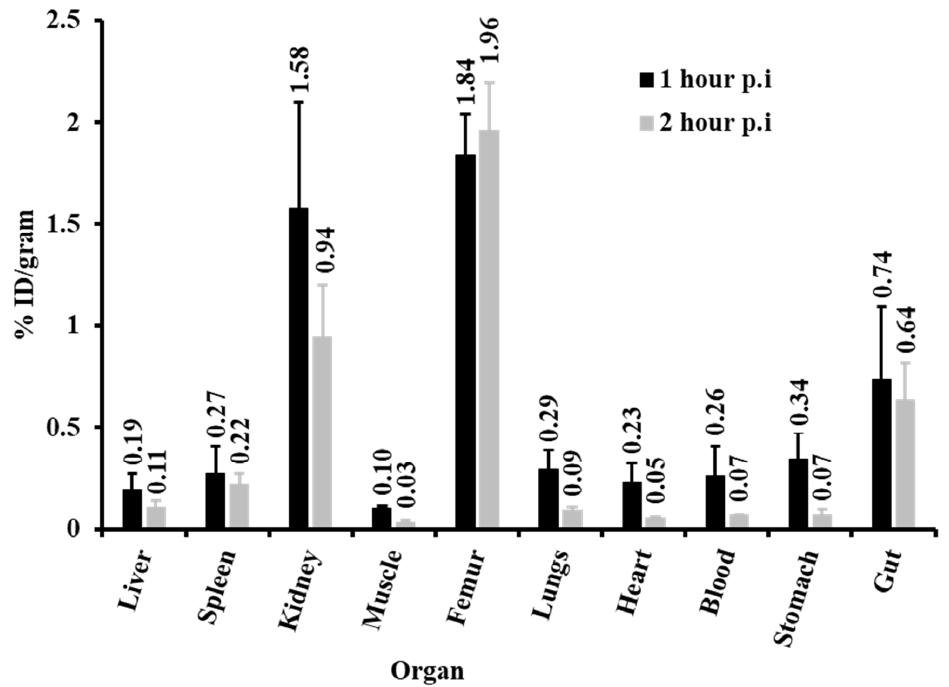
Figure 16. In vivo animal biodistribution of [ 68 Ga]Ga ‐ NODPAM in healthy Sprague Dawley rats examining its % ID/g of each organ of interest for 1 h and 2 h p.i. study. Table 7. The % ID in skeleton and bone-to-blood / muscle ratio for [ 68 Ga]Ga-NODPAM 1 h and 2 h p.i. Table 7. The % ID in skeleton and bone ‐ to ‐ blood/muscle ratio for [ 68 Ga]Ga ‐ NODPAM 1 h and 2 h p.i. Time Point % ID in Skeleton (SD) Bone-to-Blood % ID in Skeleton Time Point (SD)